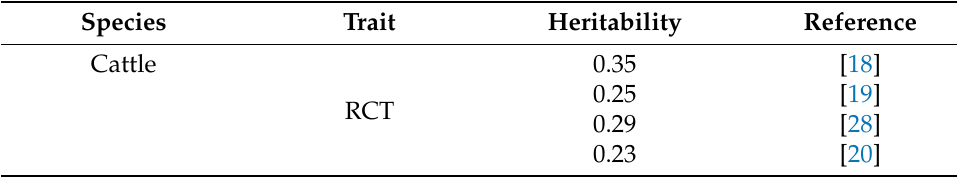
Table 2. Heritability estimates for the milk production traits in